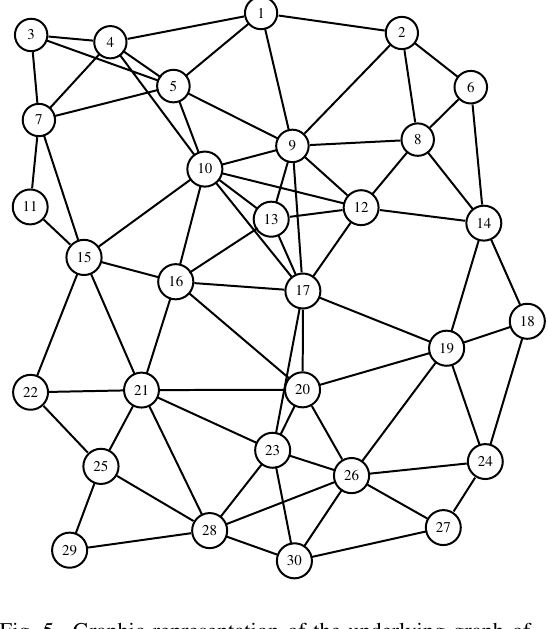
Fig. 5. Graphic representation of the underlying graph of